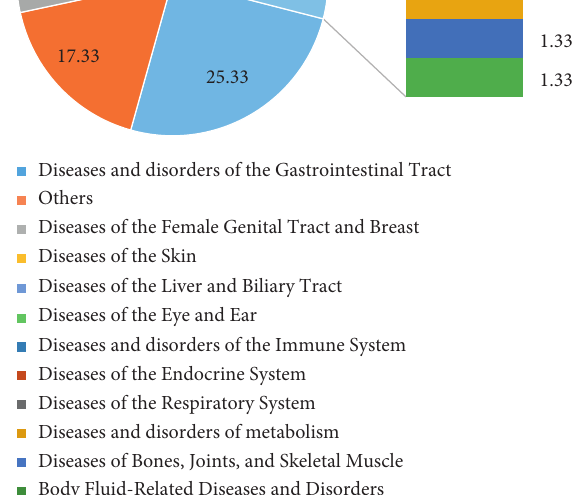
Figure 3: Frequencies of diseases and disorders treated.